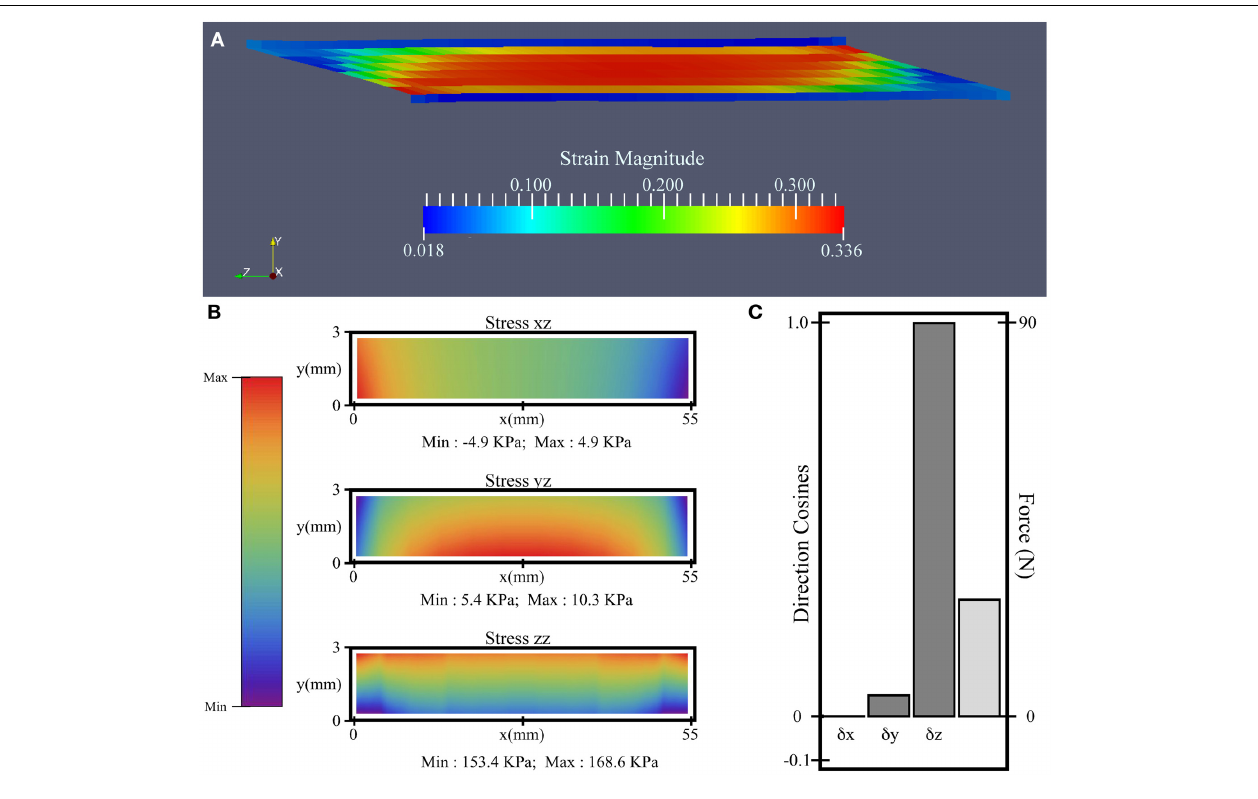
FIGURE 4 | Simulation results for the uniform activation condition with compliant aponeurosis and 10% activation. (A) Magnitude of strain. (B) “xz” and “yz” shear, and “zz” tensile stress contours on the plane